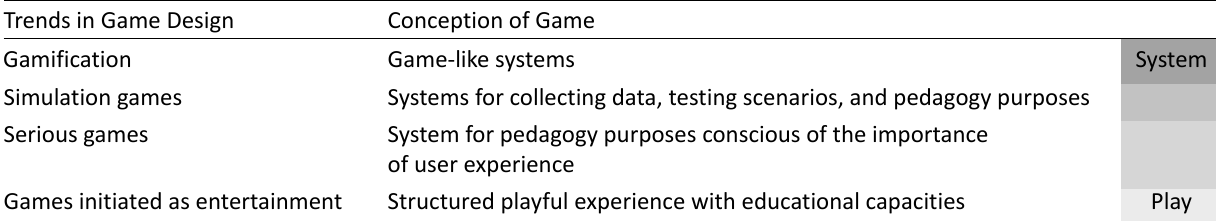
Table 2. The conception of “game” in different trends in game design. Trends in Game